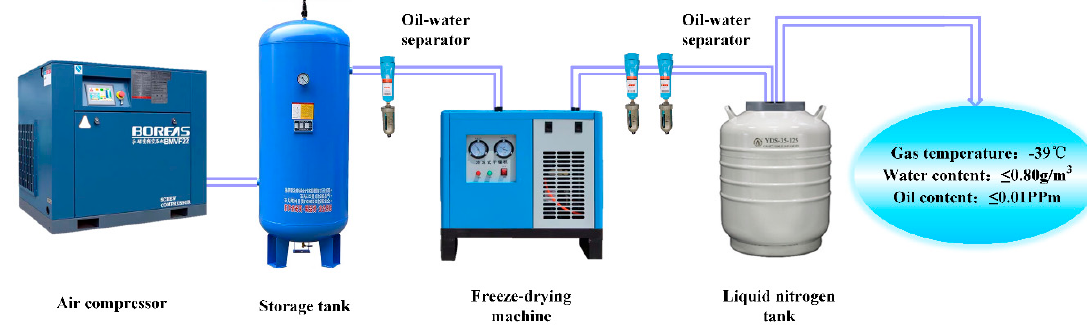
Figure 5. Liquid nitrogen cooling system.